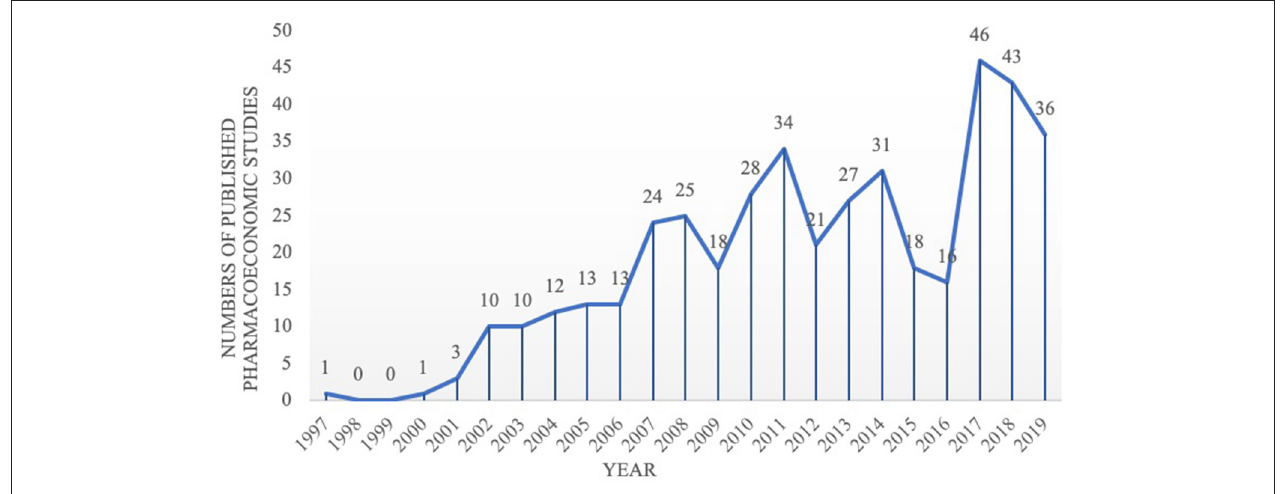
FIGURE 2 | Number of included pharmacoeconomic research publications ( N = 434).